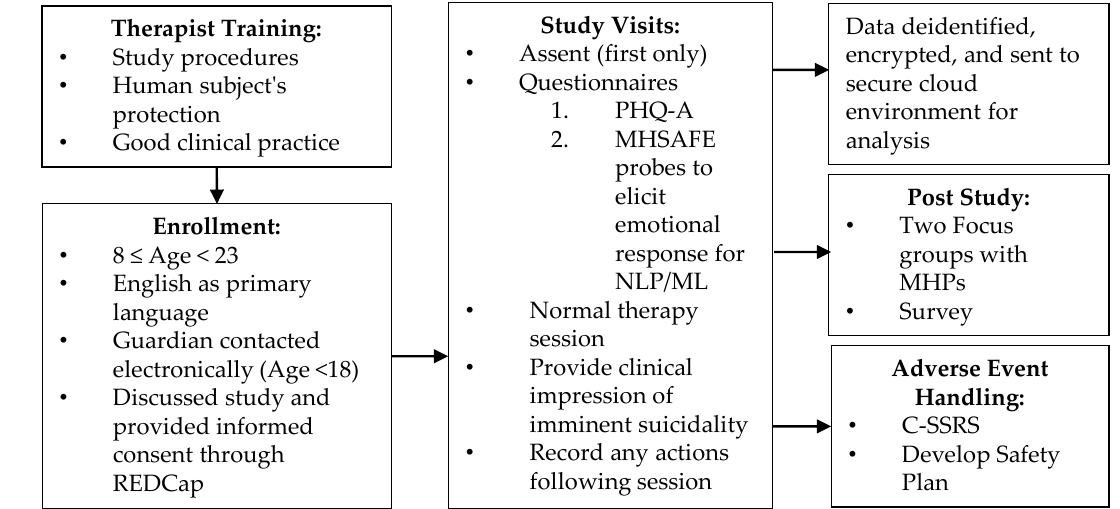
Figure 1. Schematic of study